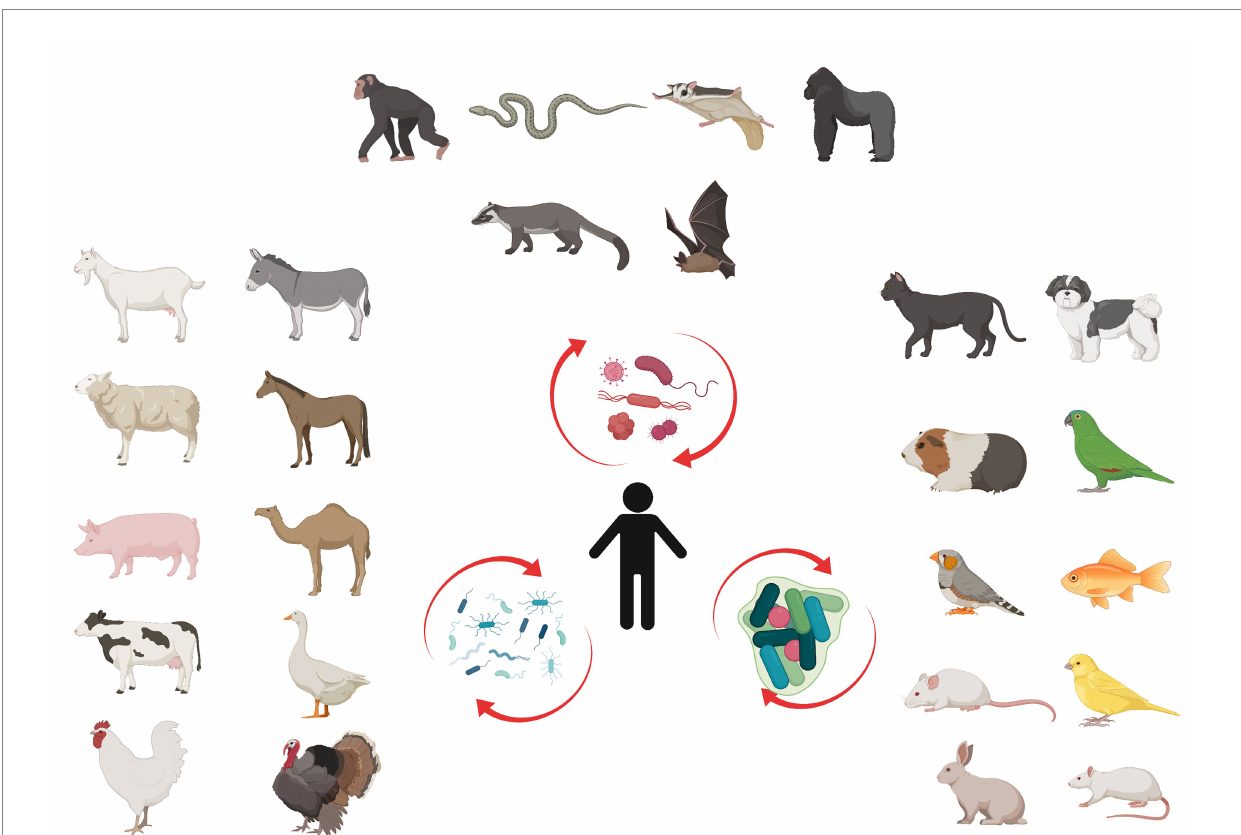
FIGURE 1 Microbiome diversity. Wildlife (above), domesticated livestock (left) and pet animals (right) have a constant influence on human microbiome. Initial changes in human microbiome trigger gradual modification called microbiome